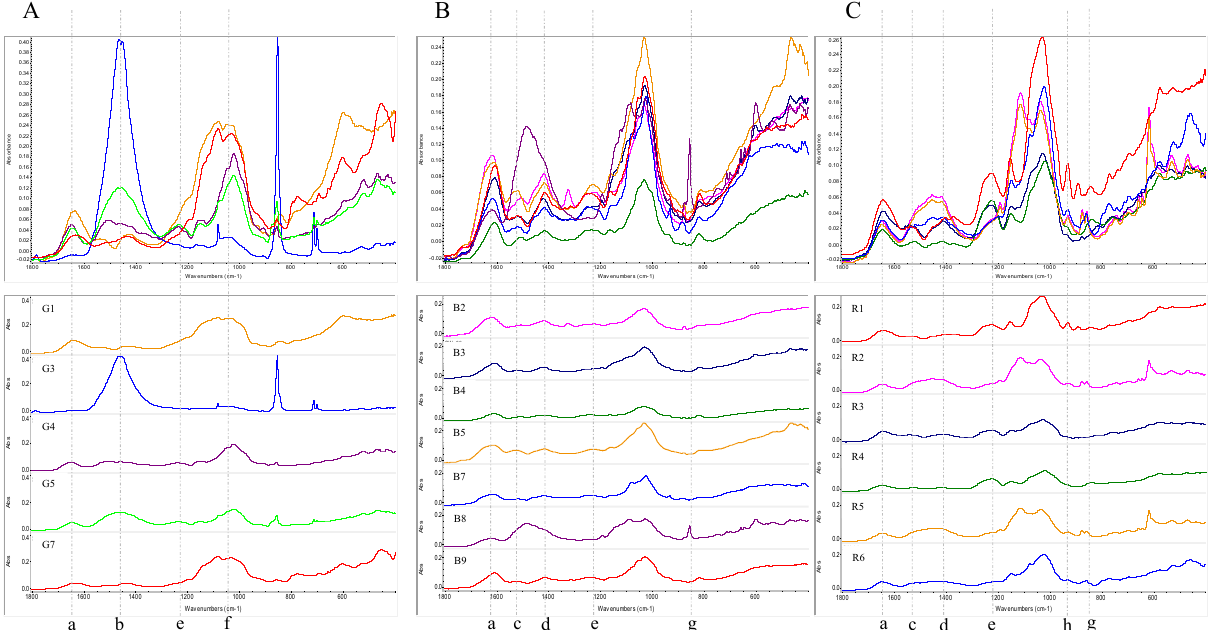
Figure 2. FT-IR spectra of raw seaweeds samples: ( A ) Chlorophyta, ( B ) Phaeophyta, ( C ) Rhodophyta. ( a ) C=C stretching (1650–1600 cm −1 ), ( b ) C–H bending; (1465–1450 cm −1 ), ( c ) N–O stretching (1550–1500 cm −1 ), ( d ) O–H bending; carboxylic acid (1440–1395 cm −1 ), ( e ) C–O stretching (1275–1200 cm −1 ), ( f) S=O stretching (1070–1030 cm −1 ), ( g ) anomeric region (950–700 cm −1 ), ( h ) C–O–C bridge in 3,6-anhydro-l-galactose (930 cm −1 ). (G1) Ulva lactuca , (G2) Caulerpa racemosa, (G3) Halimeda opuntin , (G4) Caulerpa racemosa , (G5) Caulerpa sertularioides , (G6) Ulva lactuca , (G7) Chaetomorpha antennina , (G8) Chaetomorpha crassa , (B1) Padina antillarum , (B2) Sargassum illicifolium , (B3) Sargassum polycystem , (B4) Turbinaria ornata , (B5) Stoechospermum polypodioides , (B6) Sargassum illicifolium , (B7) Sargassum illicifolium , (B8) Padina antillarum , (B9) Sargassum illicifolium, (R1) Gracilaria corticata, (R2) Gracilaria corticata , (R3) Acanthophora spicifera , (R4) Gelidiopsis variabilis , (R5) Gracilaria corticata , (R6) Jania adhaereus